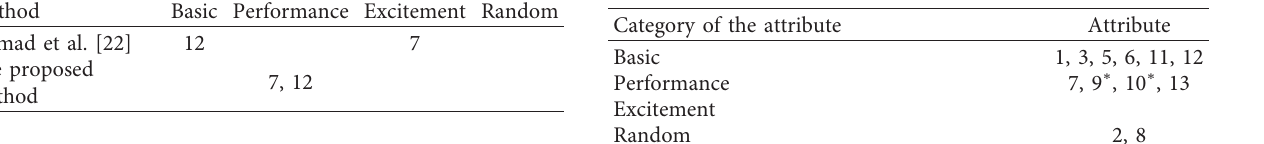
Table 10: Categories of the attributes based on the rules presented in Section 3 for the customer having the low level of customer satisfaction